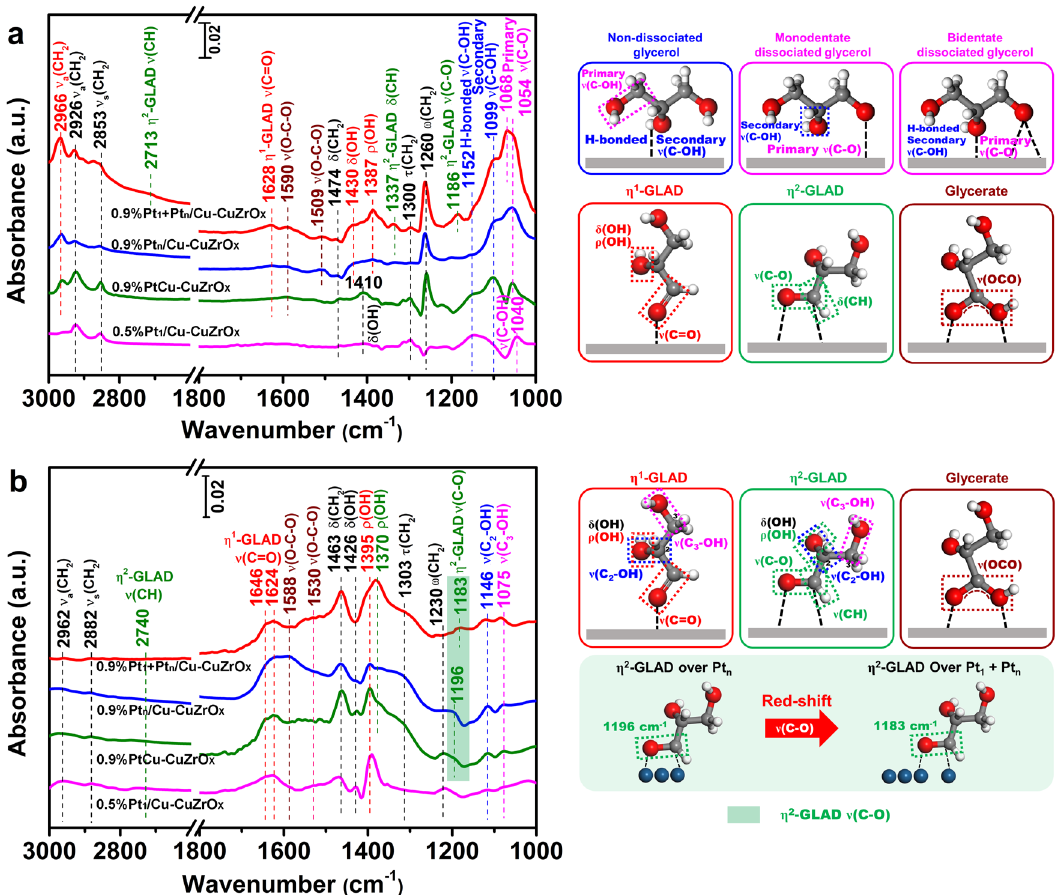
Fig.5|Theadsorptionandtheactivationofglycerolandglyceraldehyde. Insitu FT-IR spectra of the adsorption of glycerol ( a ) and glyceraldehyde ( b ) on 0.9% Pt 1 +Pt n /Cu-CuZrO x , 0.9%Pt n /Cu-CuZrO x , 0.9%PtCu-CuZrO x , and 0.5%Pt 1 /Cu-